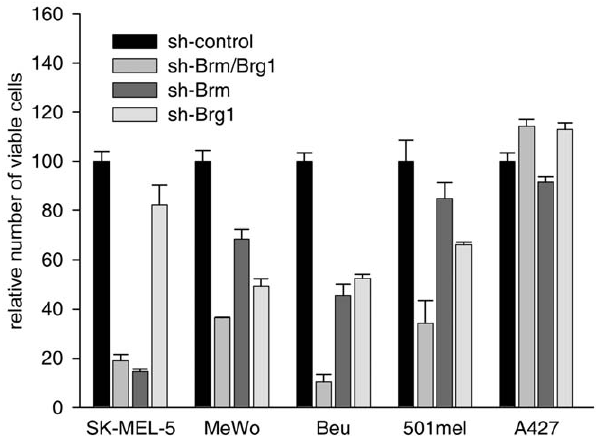
Figure 2. Viability of melanoma cell lines after shRNA- mediated depletion of BRG1, BRM, or both. Viability of each cell line is indicated in the histogram. The results are expressed as per cents of control shRNA-transduced cells. The cells were infected with appropriate lentivirus, replated two days later into 12-well plates, and viability was determined after next 3 days. The values are means of triplicates + -SE. One of the three independent experiments is shown. No decrease of viability was observed in BRM/BRG1-null A427 cells, used as a negative control. The knockdown of BRG1, BRM or common BRG1/ BRM was efficient (see Figures 1, 3B, and 4, and Figure 3 in our previous article [26]).